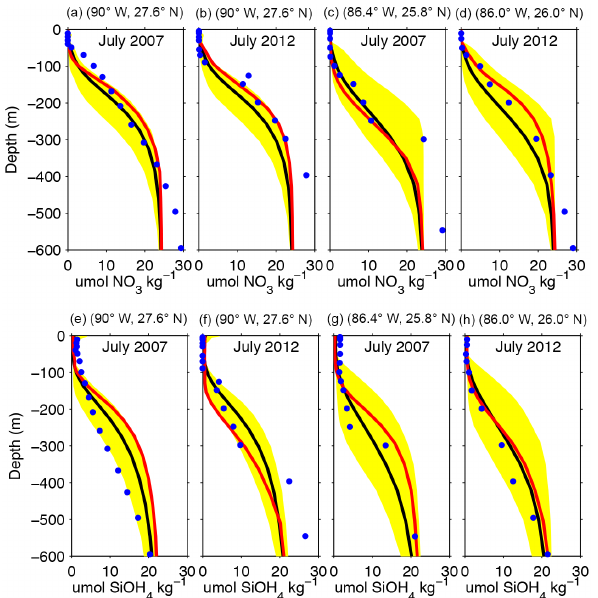
Figure 8. Comparison between profiles of nitrate and silicate de- rived from model outputs (red lines) and GOMECC data (blue dots). The model’s climatological mean and range for July are also shown as black line and yellow area, respectively. (a, b, e, f) show the pro- files associated with the most oceanic station from the Mississippi line and (c, d, g, h) for the Tampa line for GOMECC cruises 1 (July 2007) and 2 (July 2012).